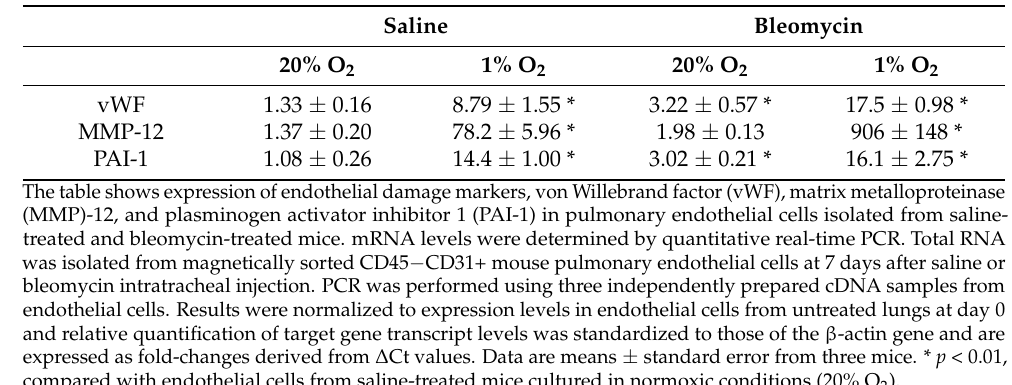
Figure 3. Fibrotic mediator proteins released from endothelial cells. Protein levels of TGF- β 1 ( A ), CTGF ( B ), PDGF-B ( C ), PDGF-C ( D ), and PDGF-D ( E ) released from endothelial cells were quanti- fied by ELISA. Data are means ± standard error of the mean for three mice. * p < 0.05. Figure 4. Total collagen content in endothelial cells. Total soluble collagen content in the culture medium from endothelial cells isolated from saline- and bleomycin-treated lungs was quantified by the Sircol assay. Results are means ± standard error of the mean from three mice per group. * p < 0.05. 2.5. Phenotypic Changes in Endothelial Cells Cultured under Hypoxic Conditions Next, we explored the phenotypic changes of endothelial cells from bleomycin- treated lungs cultured under hypoxic conditions using immunofluorescence analysis. We fluorescently stained endothelial cells for α -SMA and CD31 (Figure 5). The percentage of